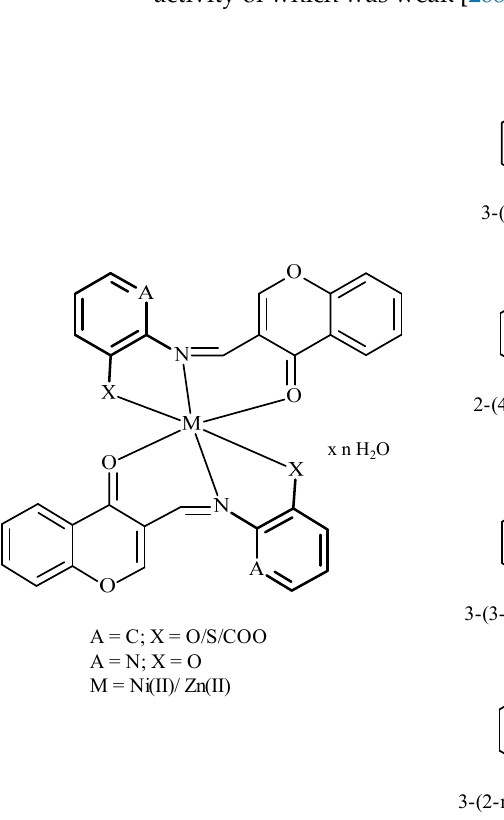
Figure 9. Structures of compounds 55 – 58 (Schiff base ligands) and predicted structure of their complexes with Ni(II) and Zn(II) ions.